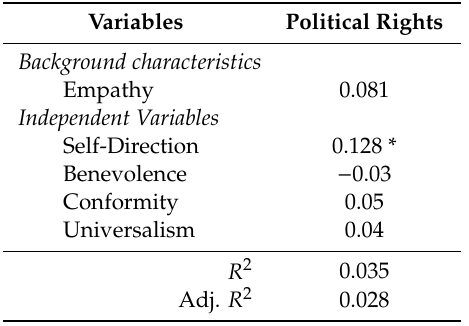
Table 13. Regression analysis for political rights with weights ( β ) for each variable and total explained variance ( R 2 and adjusted R 2 ).